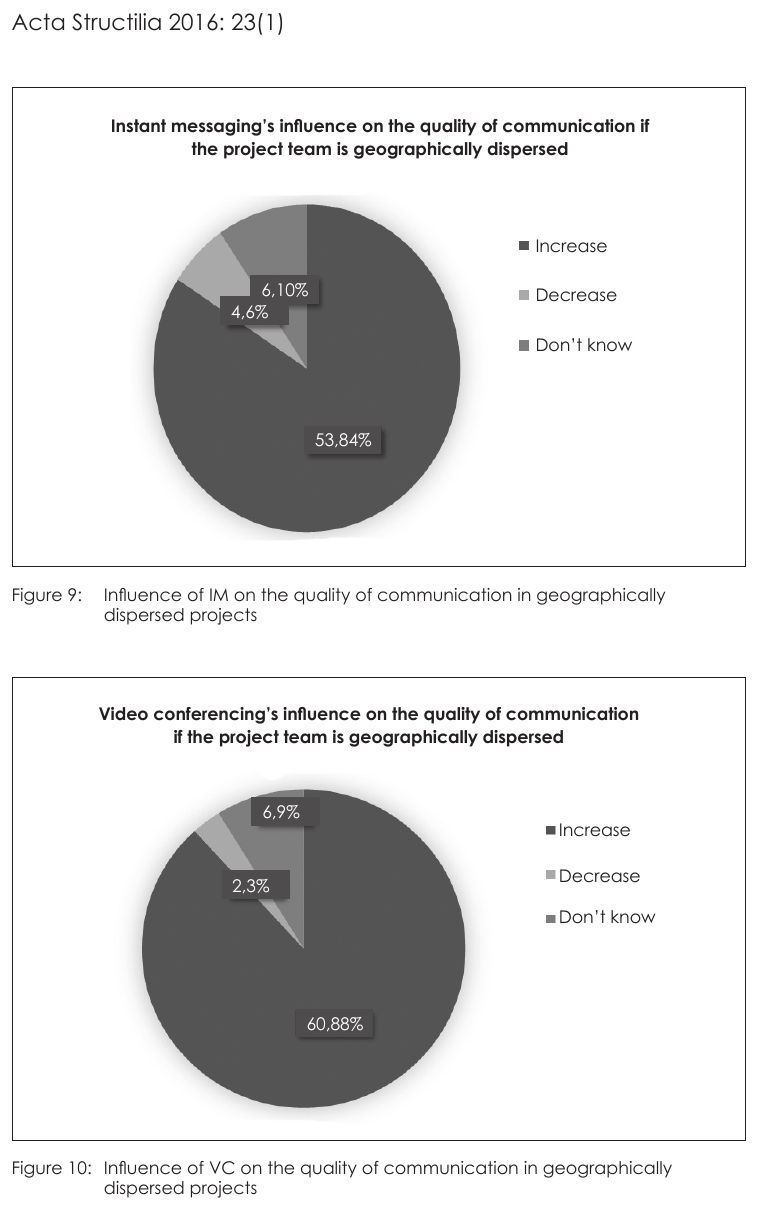
Figure 10: Influence of VC on the quality of communication in geographically dispersed projects It was established that 84% of the respondents found IM and 88% found VC to increase the quality of the communication if the